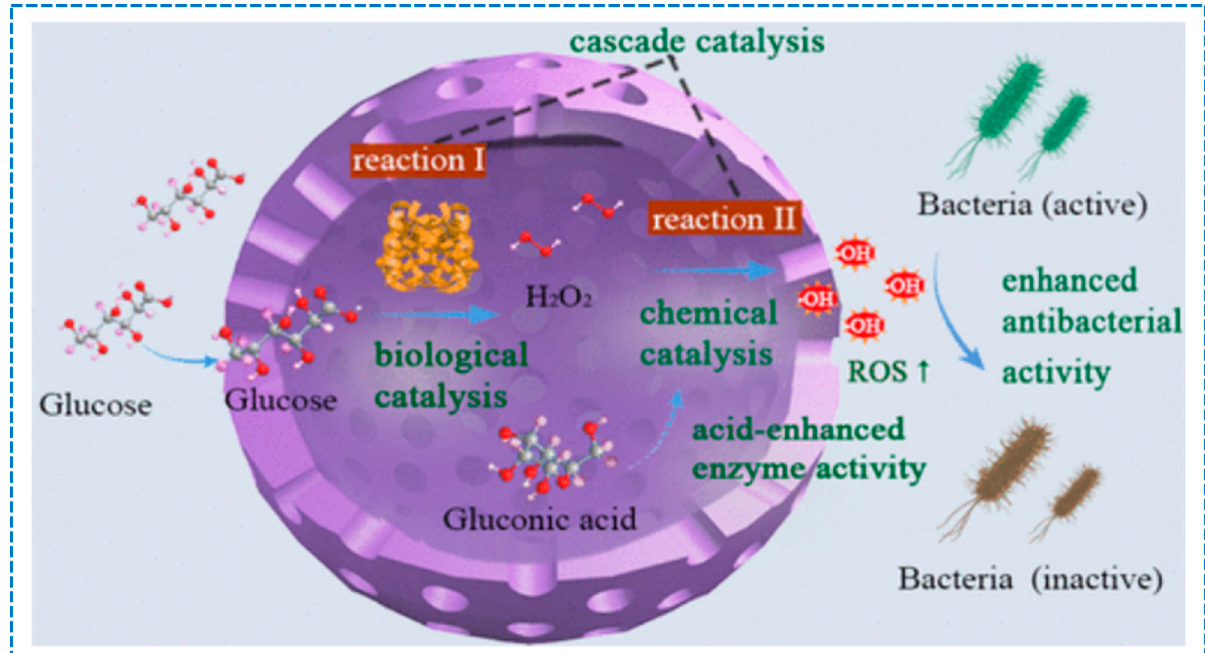
Figure 3. Antibacterial mechanism of nanoscale cerium oxide [73]. Copyright 2021 American Chemical Society.